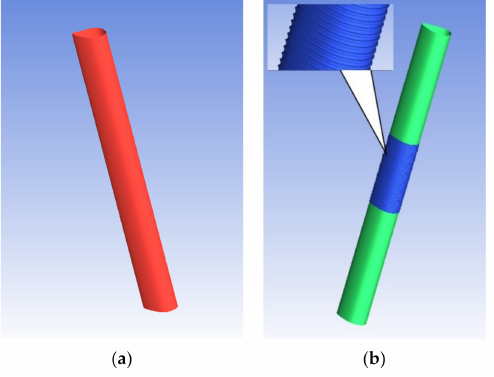
Figure 6. Numerical models of the tip section of the blade: ( a ) without rings; ( b ) with